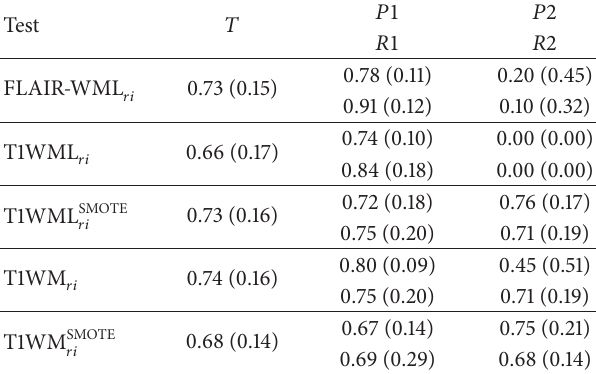
Table 4: Results are reported as mean with standard deviation in brackets, 𝑚 ( 𝑠 ), over 10-fold cross validation, classifying AD versus LBD. 𝑇 = total accuracy, 𝑅 = recall, and 𝑃 = precision. 1 for class AD and 2 for class LBD. ROI is either WM for white matter or WML for white matter lesion